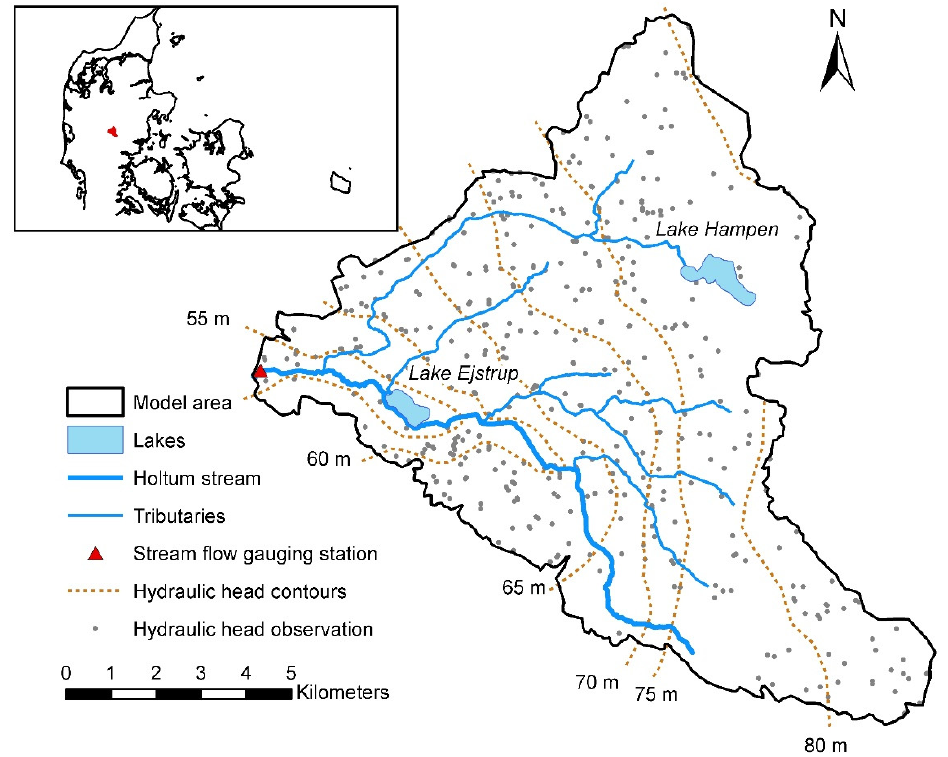
Figure 1. Study area. The insertion depicts the study area in red situated in the western part of Denmark.